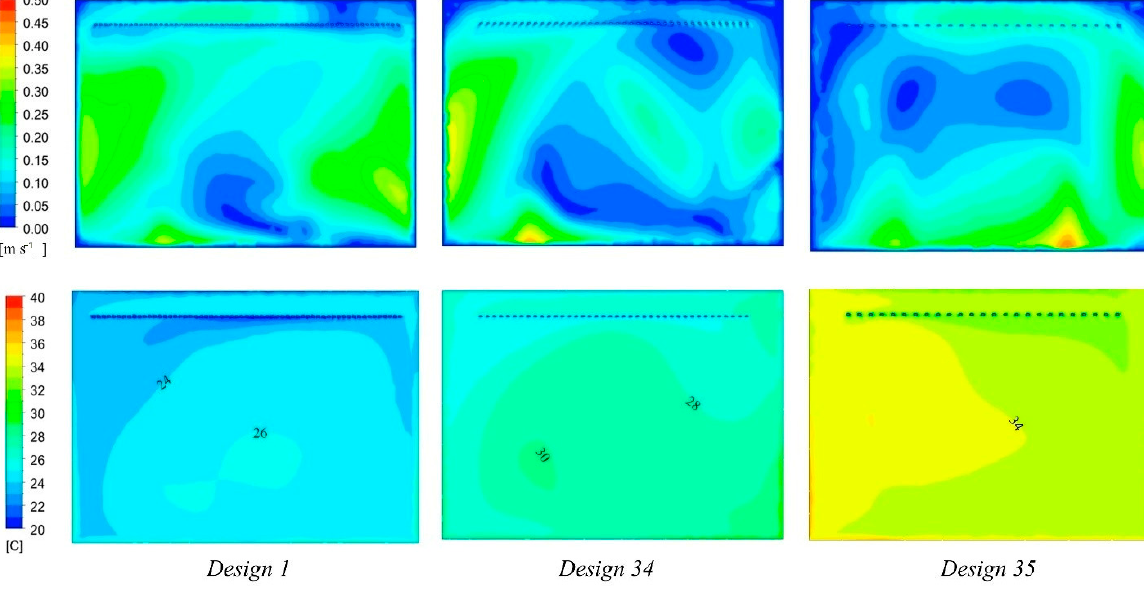
Figure 16. Velocity and temperature contours in Design 1, Design 34, and Design 35 under a cooling load of 1405.02 W.